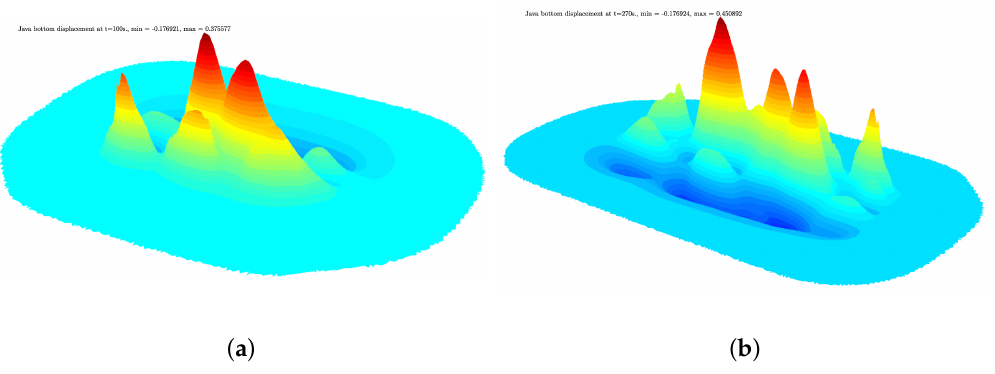
Figure 8. Bottom displacement at t = 100 s (( a ), min = − 0.18 m, max = 0.38 m) and at t = 270 s; (( b ), min = − 0.18 m, max = 0.45